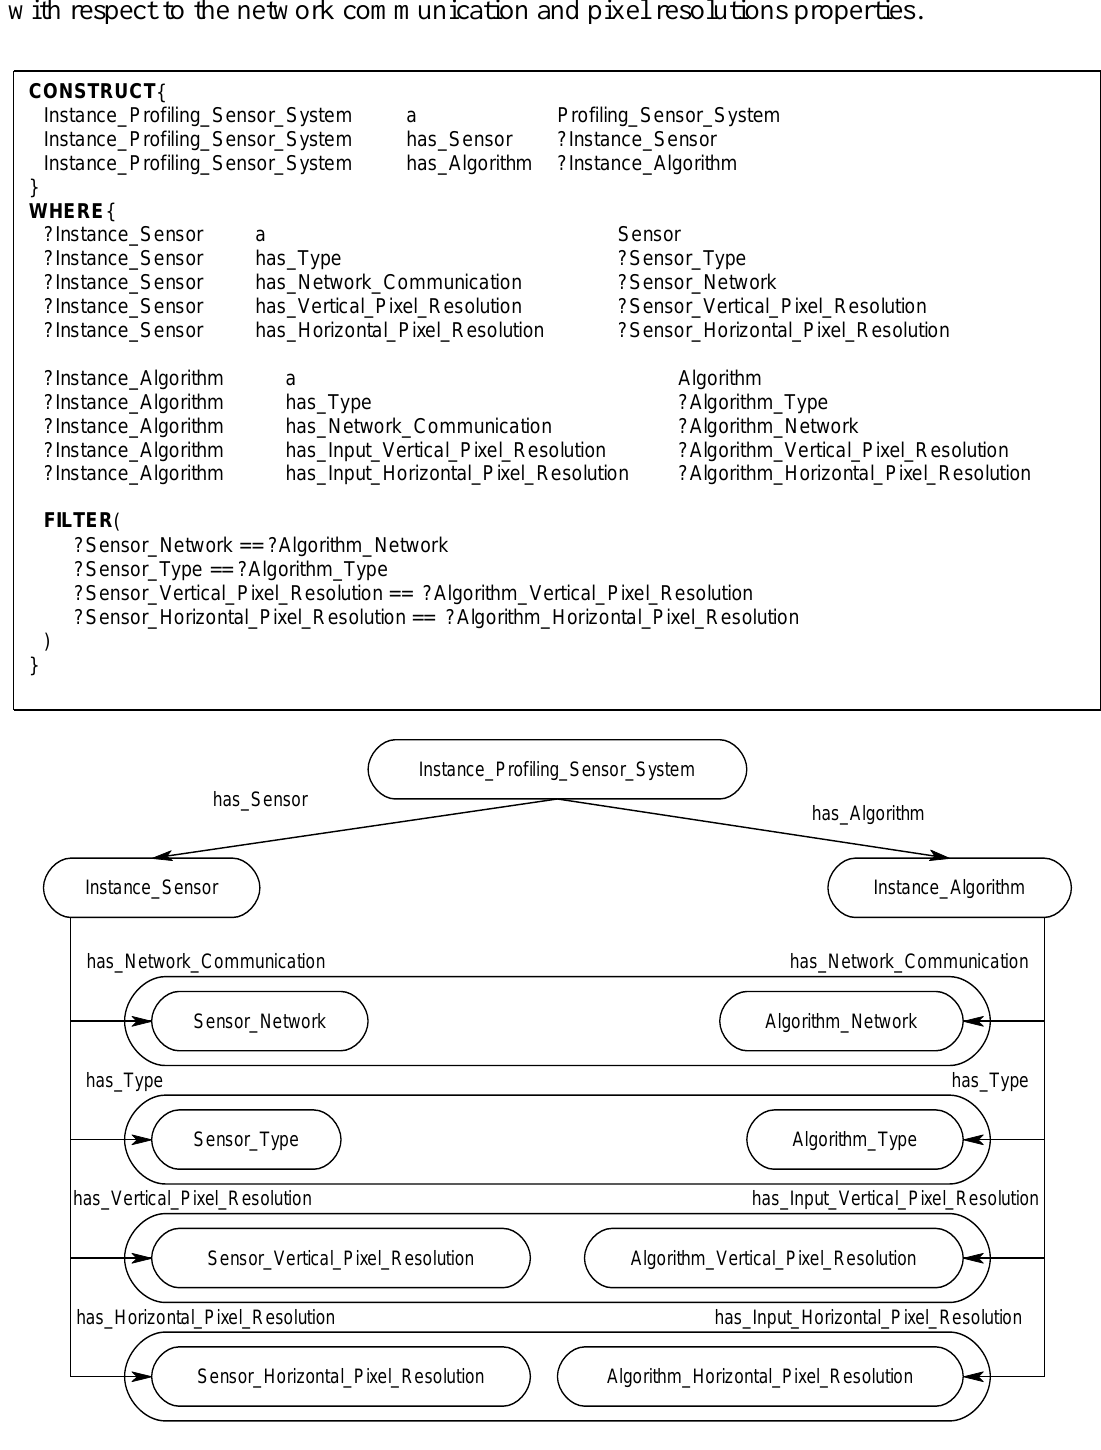
Figure 16. Sample rule and instance diagram. The rule returns an instance of a Profiling_Sensor_System if the Algorithm instance and Sensor instance are type compatible with respect to the network communication and pixel resolutions